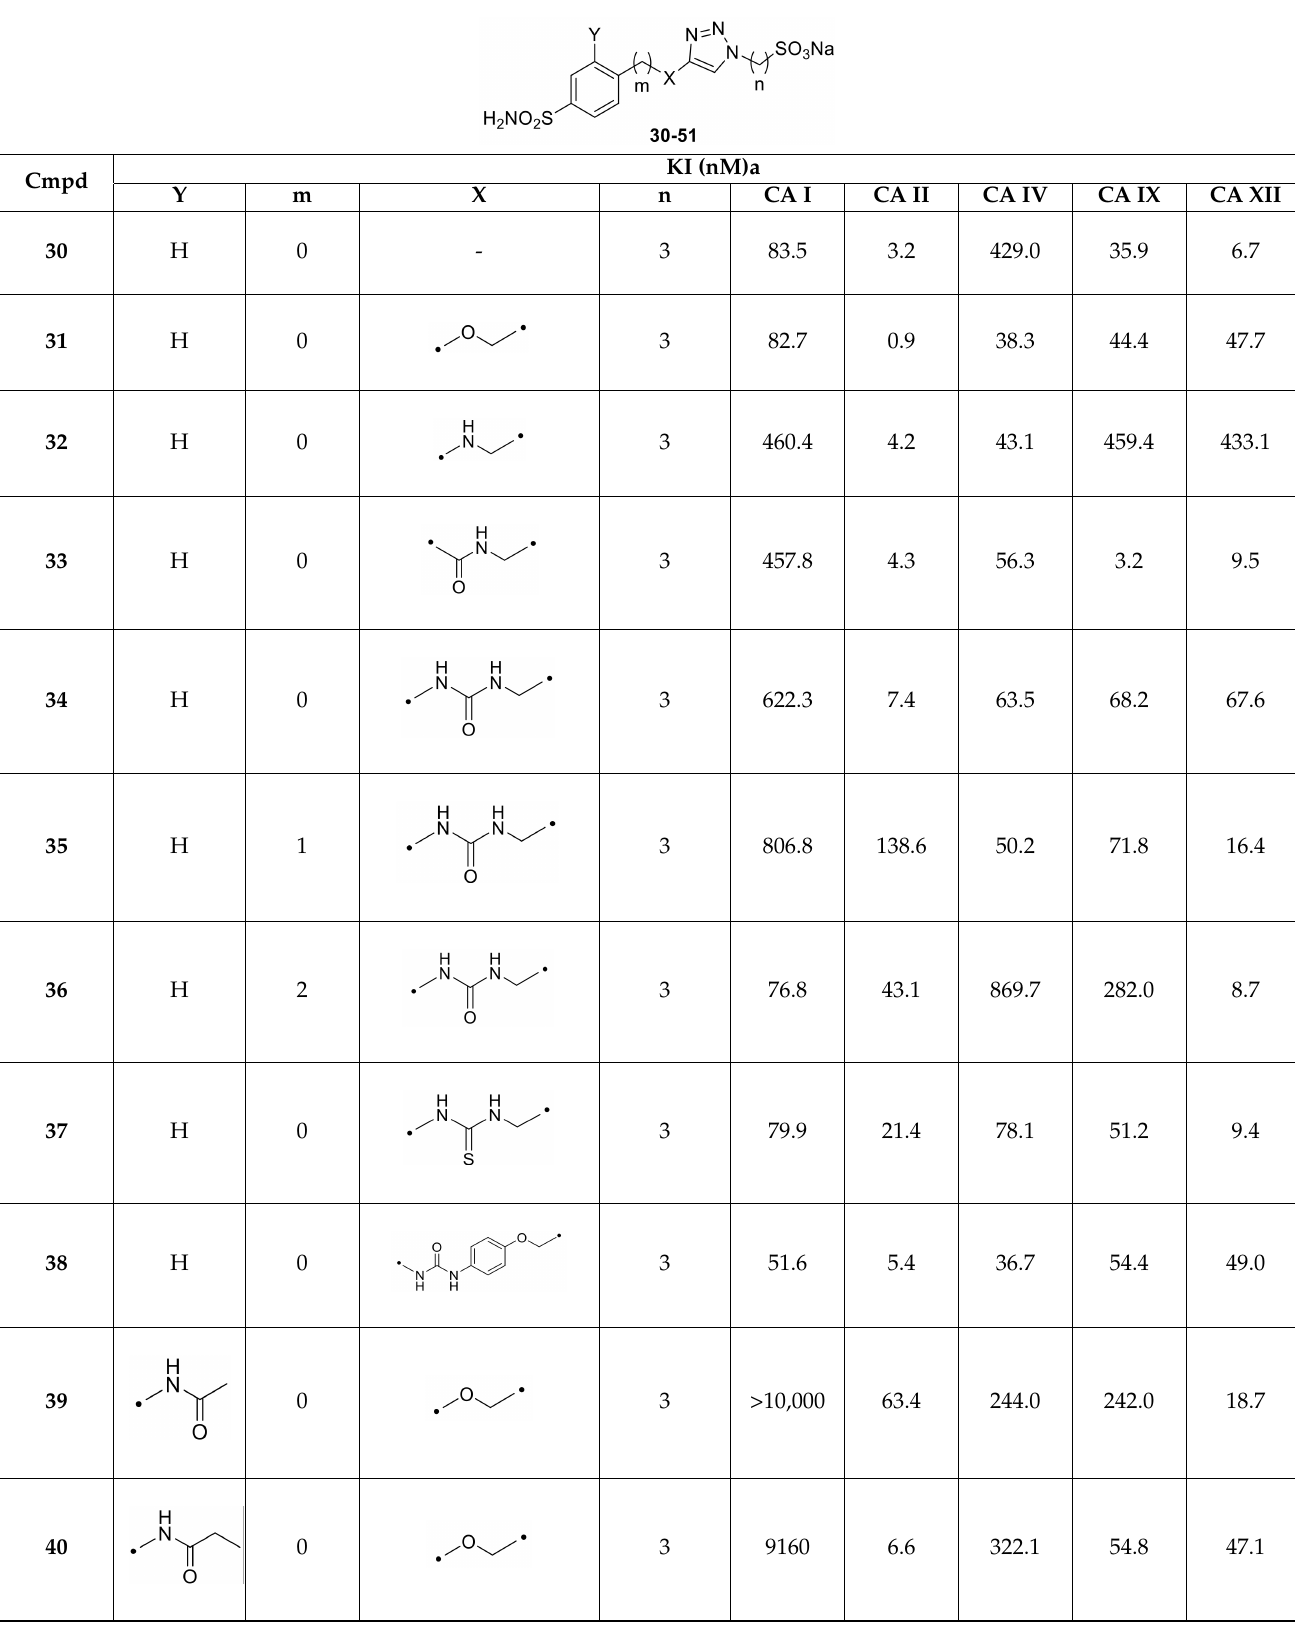
Table 1. Inhibition data of CA isoforms I, II, IV, IX, and XII with sulfonamides 30 – 51 and the standard sulfonamide inhibitor AAZ by a stopped flow CO 2 hydrase assay